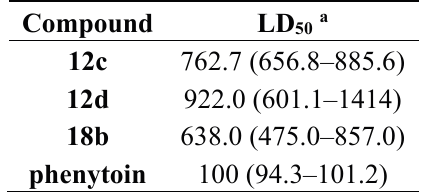
Table 4. The acute toxicity of compounds in intrapertioneal